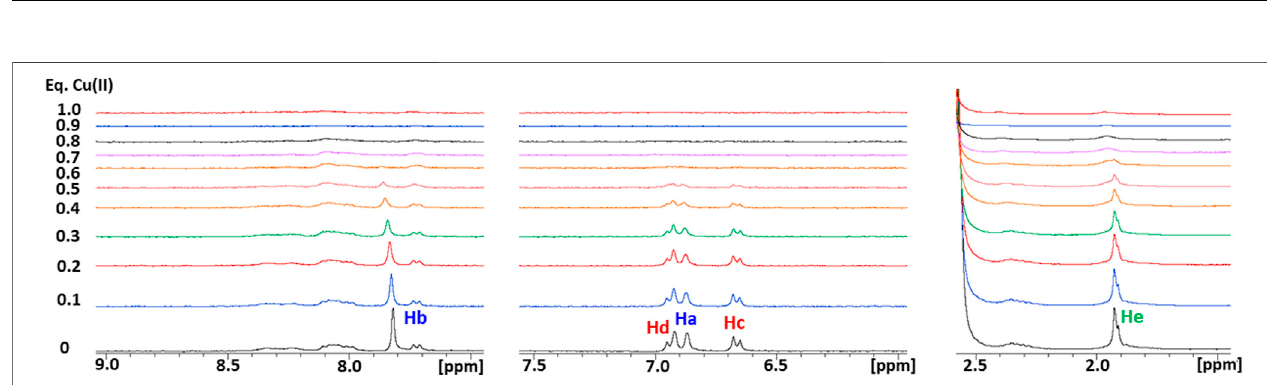
Frontiers in Molecular Biosciences | www.frontiersin.org May 2022 | Volume 9 | Article 897621